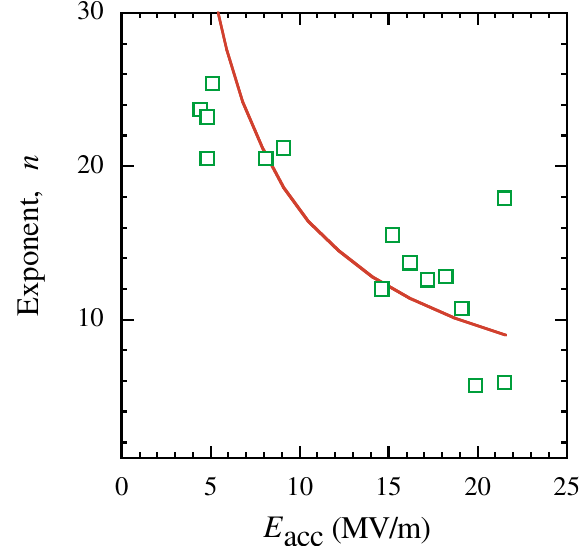
(cid:9) during condi- acc